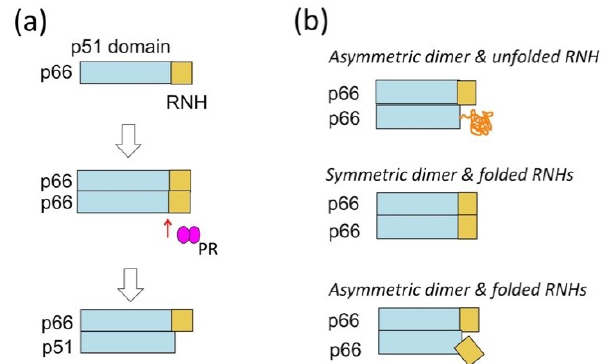
Figure 3. ( a ) RT maturation process, i.e., the formation of p66 / p66 and processing to p66 / p51, and ( b ) three homodimer structural models: asymmetric homodimer with one unfolded RNH domain, proposed based on solution NMR experiments of p66 / p66, p66 / p51, and p51 [70,101,102]; symmetric homodimer with both RNH domains folded, proposed based on solution NMR experiments of p66 / p66 and p51 [100]; or asymmetric homodimer with both RNH domains folded, proposed based on electron spin resonance (ESR) experiments [103].